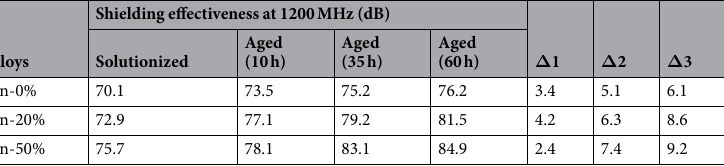
Table 3. EMI shielding effectiveness of Mg-3Sn alloy in various states. * Δ 1 = aged (10 h)–solutionized, Δ 2 = aged (25 h)–solutionized, Δ 3 = aged (60